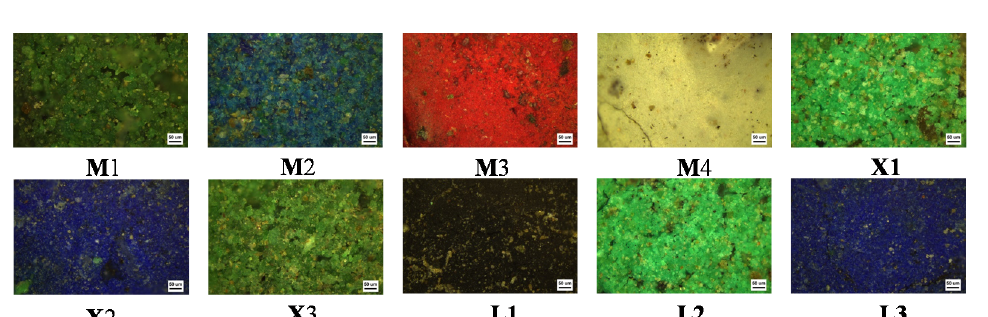
Figure 2. Micro pictures of pigment samples.